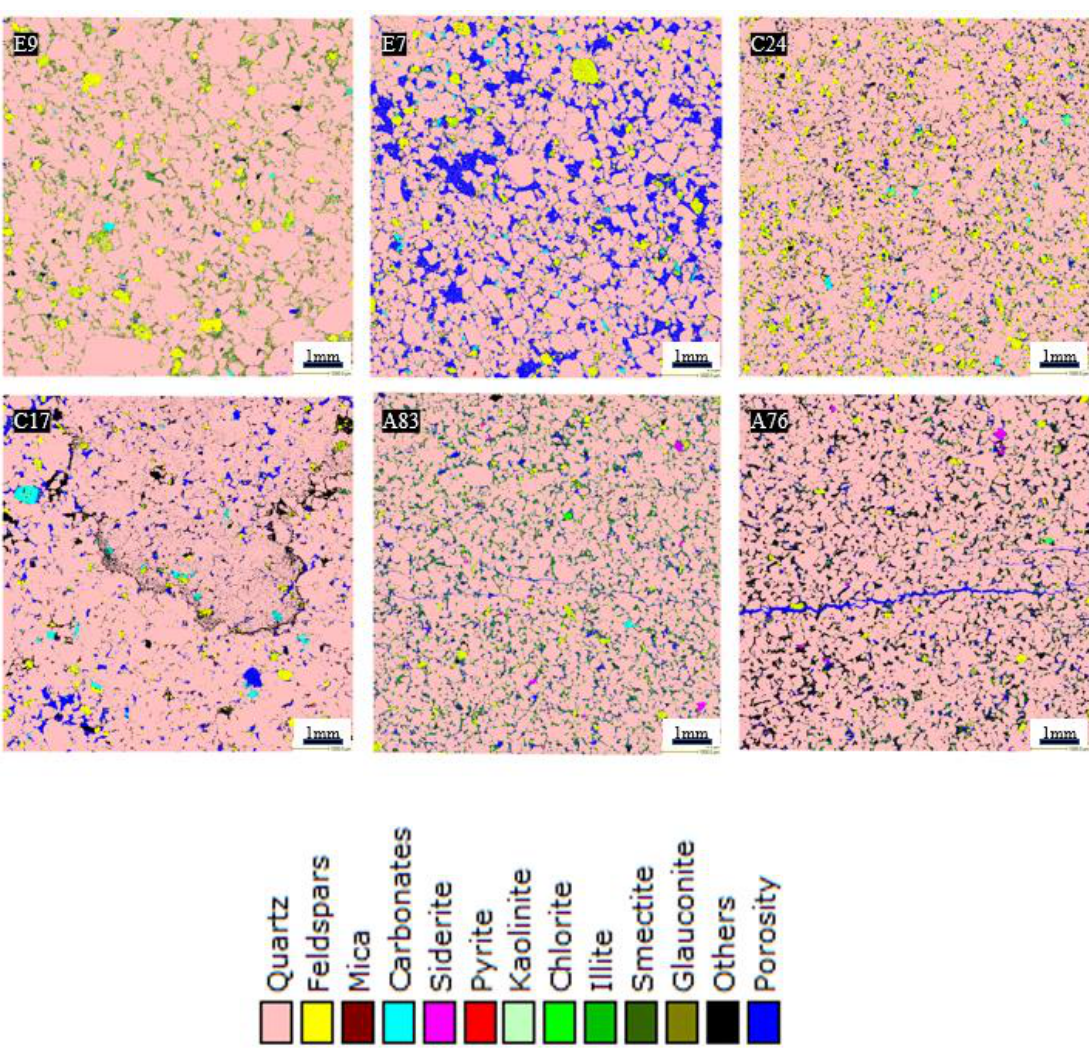
Figure 11. QEMSCAN images of samples in porosity group 2 ( > 7% porosity). The color codes for di ff erent minerals and pores are shown in the legend.